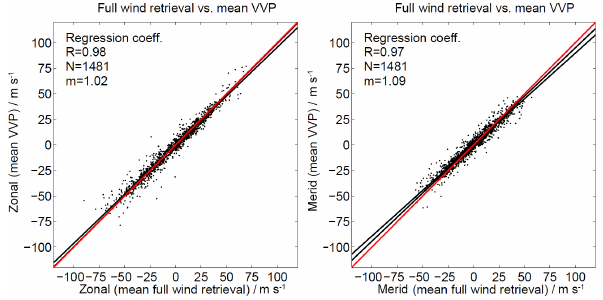
Figure 13. Scatter plots of mean zonal and meridional winds ob- tained from the full wind retrieval and VVP. The mean is computed as average over the domain